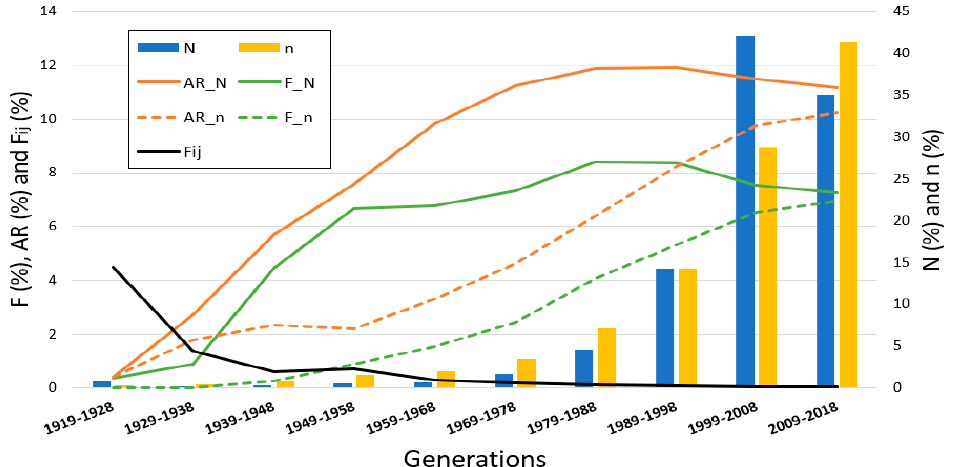
Figure 2. Census evolution of the Pura Raza Español horse (N = 328,706) and their common ancestors (n = 10,244), average inbreeding coefficient (F_N and F_n), average relatedness coefficient (AR_N and AR_n) and average partial inbreeding value (F ij ) by generational intervals.